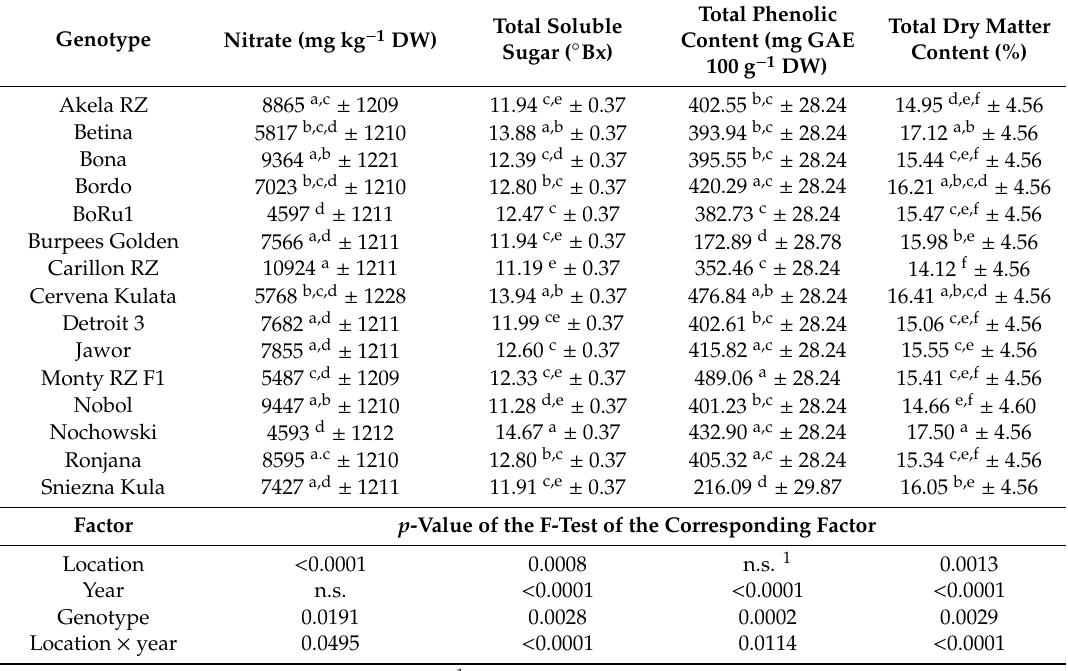
Table 1. Mean values and ANOVA of results of the content of nitrate (mg kg − 1 dry weight